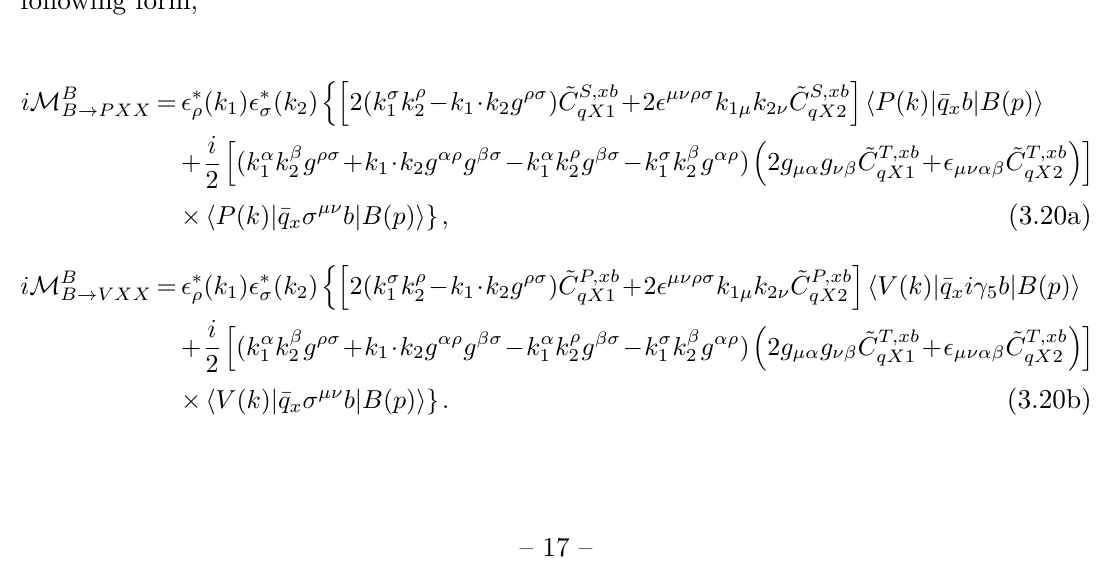
Figure 5 . Constraints on the effective new physics scale for the 4 dim-6 operators O V,A function of the DM mass m from B → K ( π ) /E